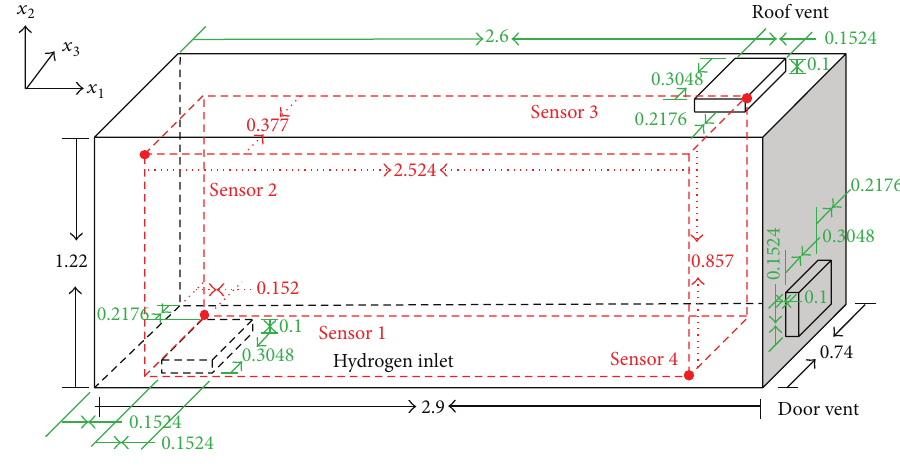
Figure 1: The ventilation model.